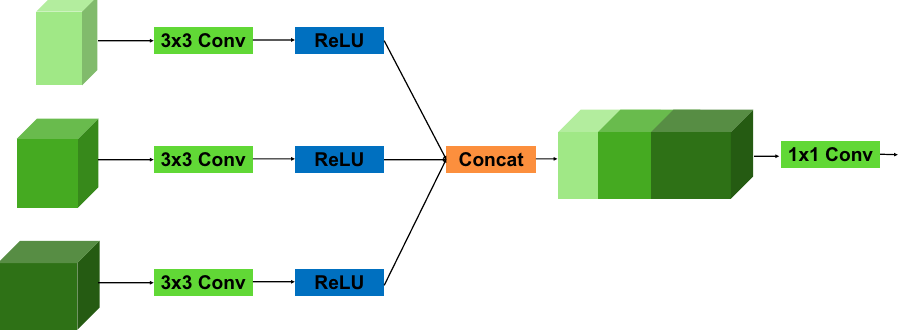
Figure 7. Illustration of the multilevel feature aggregation (MLFA)